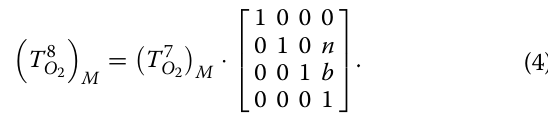
Frame {7} corresponds to the last frame of the spherical joint on the mobile platform. To obtain the pose of the end effector tip from {O 2 }, another frame {8} is assigned at the tip of the end effector as shown in Figure 4. The pose of the end effector tip from global frame {O 2 } for the middle leg is obtained from Eq. (4),